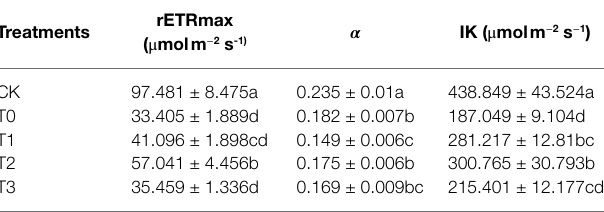
TABLE 3 | Effect of different concentrations of trehalose on the fitting parameters of light–response curve in tomato leaves under saline conditions.